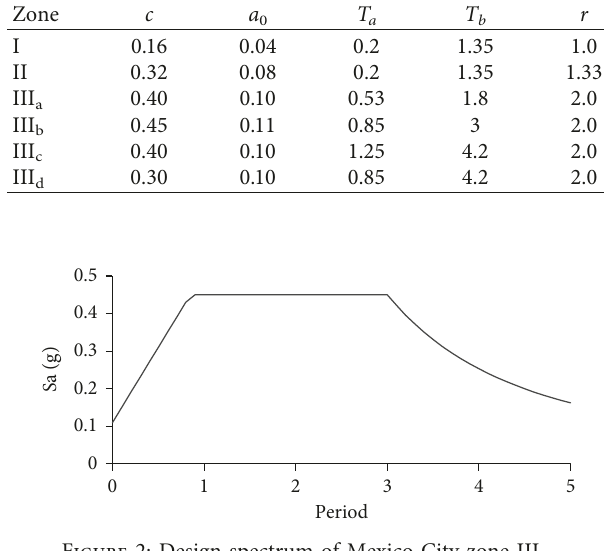
Table 1: Parameter values to calculate the acceleration spectra. Zone